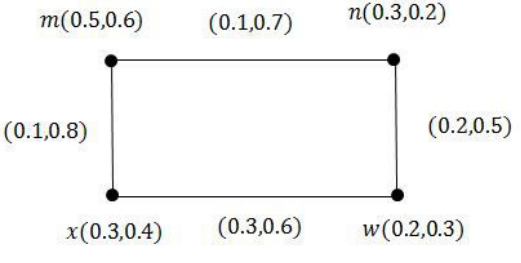
Figure 4. Neighborly Irregular Vague Graph (NIVG) ( G